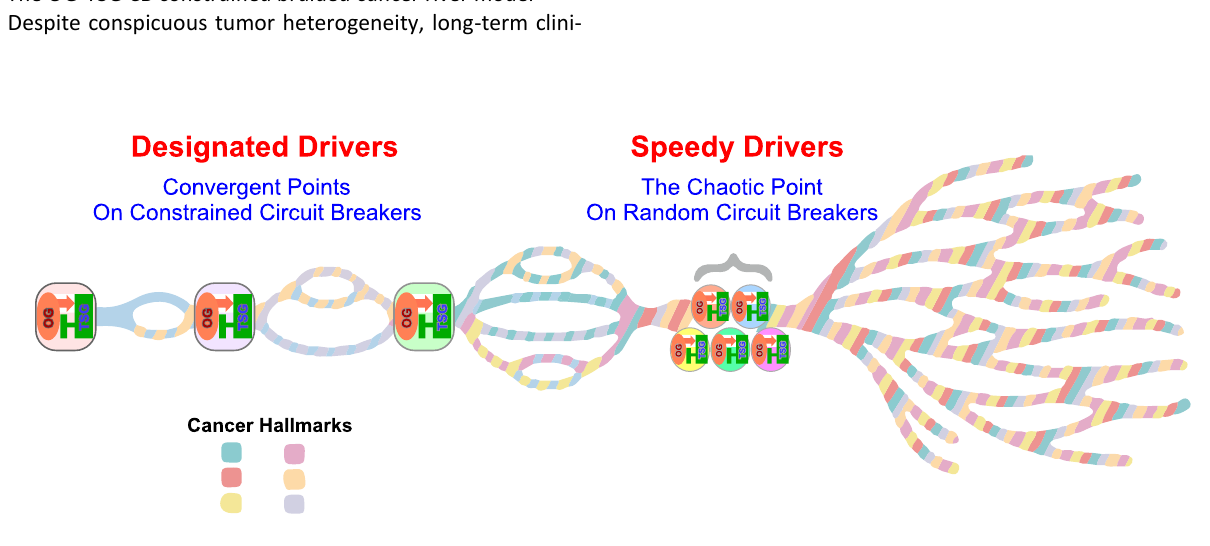
FIGURE 2. The diagram depicts the “OG -TSG CB Constrained Braided Cancer River” model to explain the non -randomness of cancer evolution and devise personalized cancer treatment